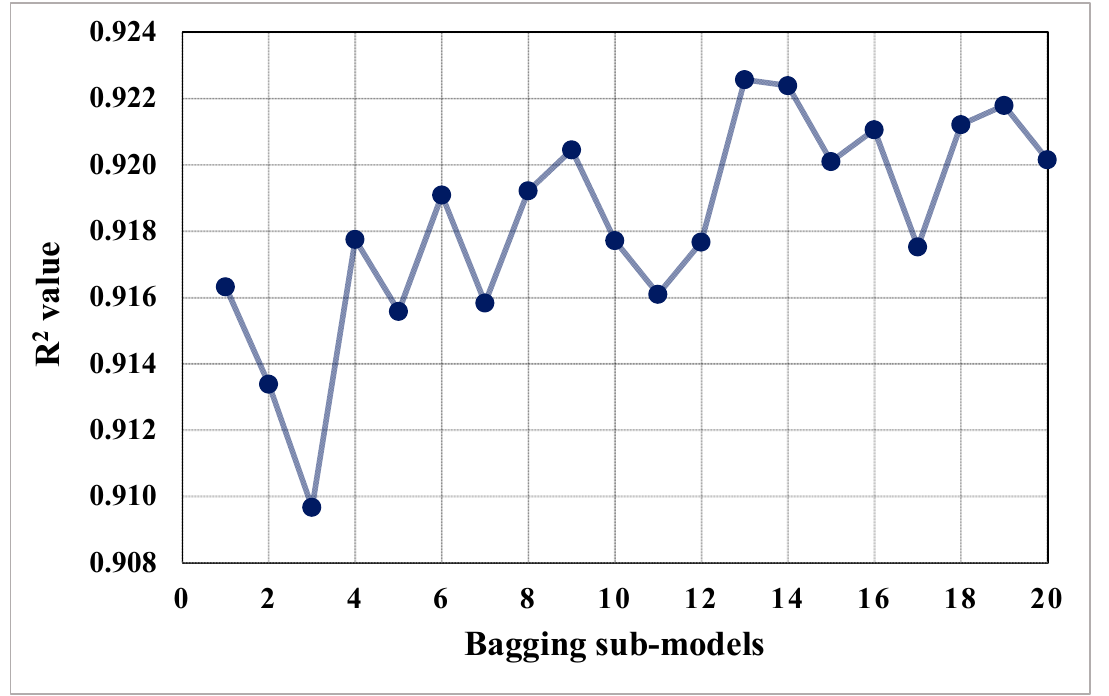
Figure 12. Coefficient of determination (R 2 ) values of bagging sub-models.